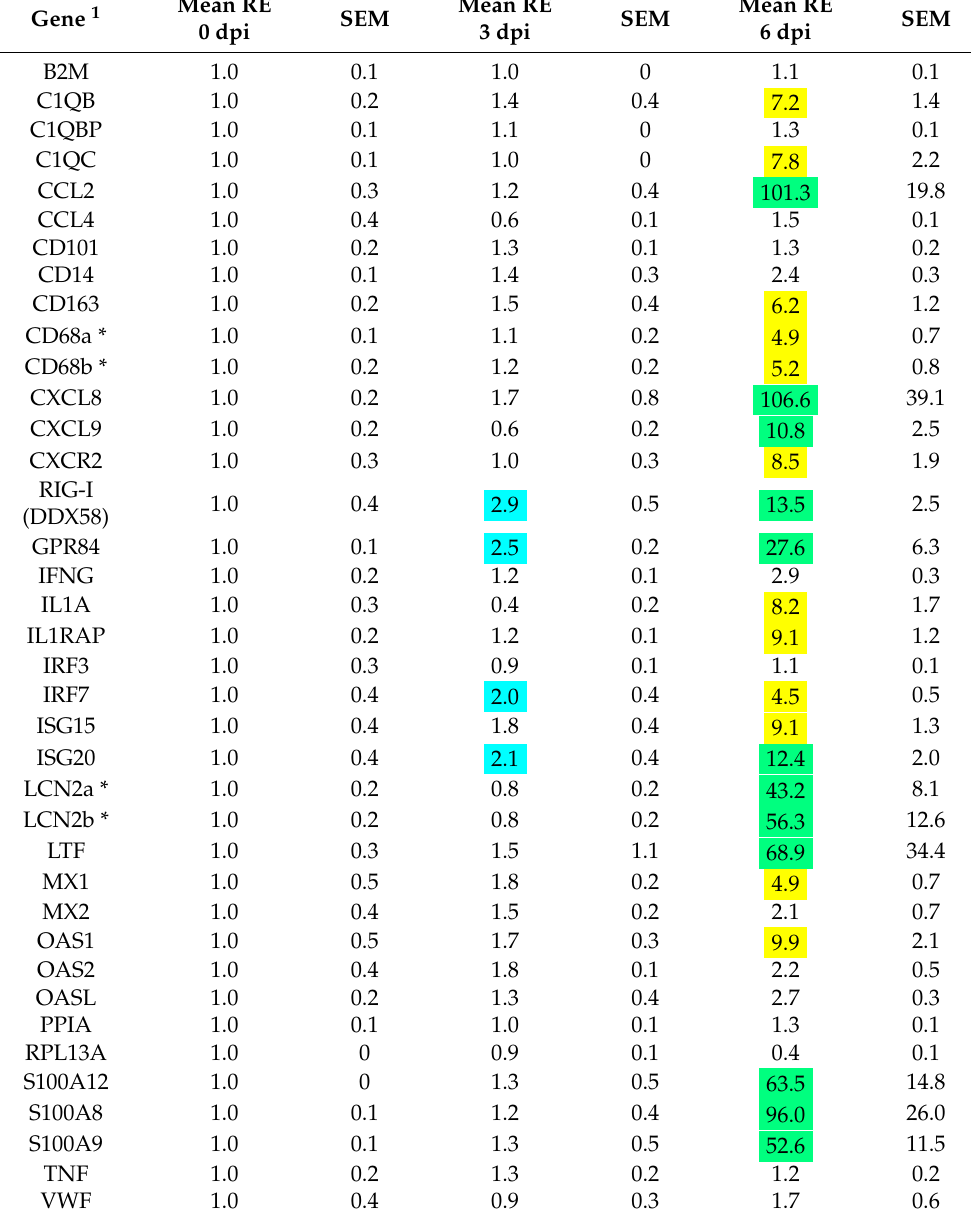
Table 2. The mean relative expression (RE) levels (plus SEM) of selected genes in the 4 pigs inoculated with ASFV in PBMCs collected at 0, 3 and 6 dpi as determined by qPCR assays. In each case, the relative expression of each gene in the pigs at 0 dpi was set to 1 and other results for each gene for that pig compared to this value. As in Table 1, genes that were increased in expression at 6 dpi by >3-fold or >10-fold compared to 0 dpi are highlighted in yellow and green, respectively. Genes increased by ≥ 2-fold at 3 dpi are highlighted in